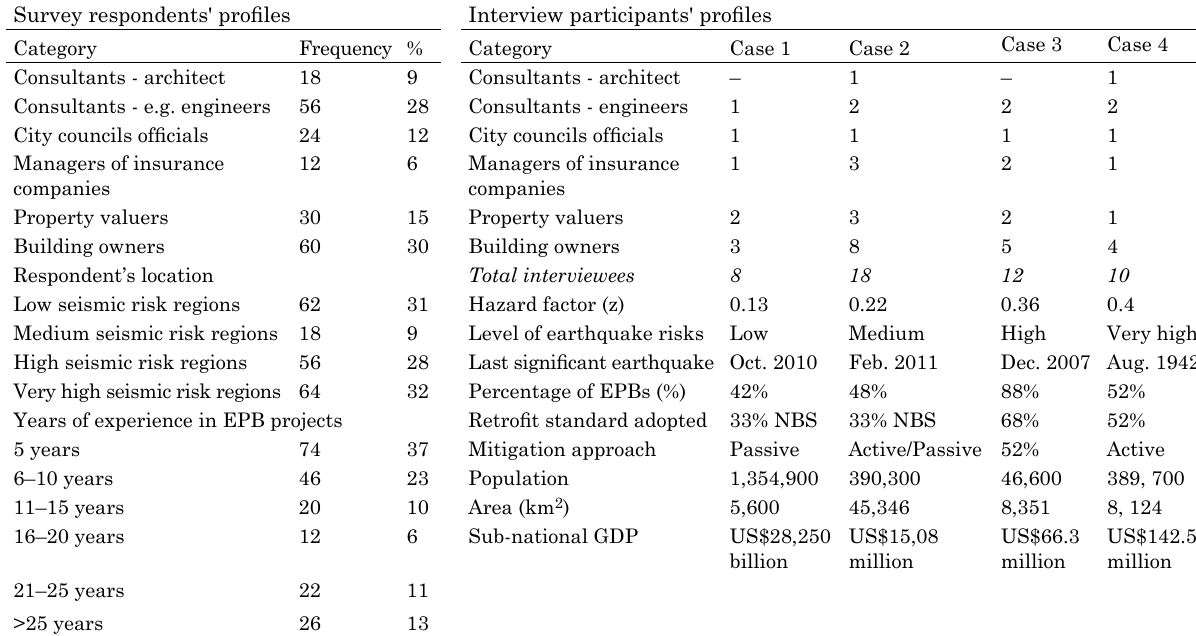
Table 1. Profile of research participants